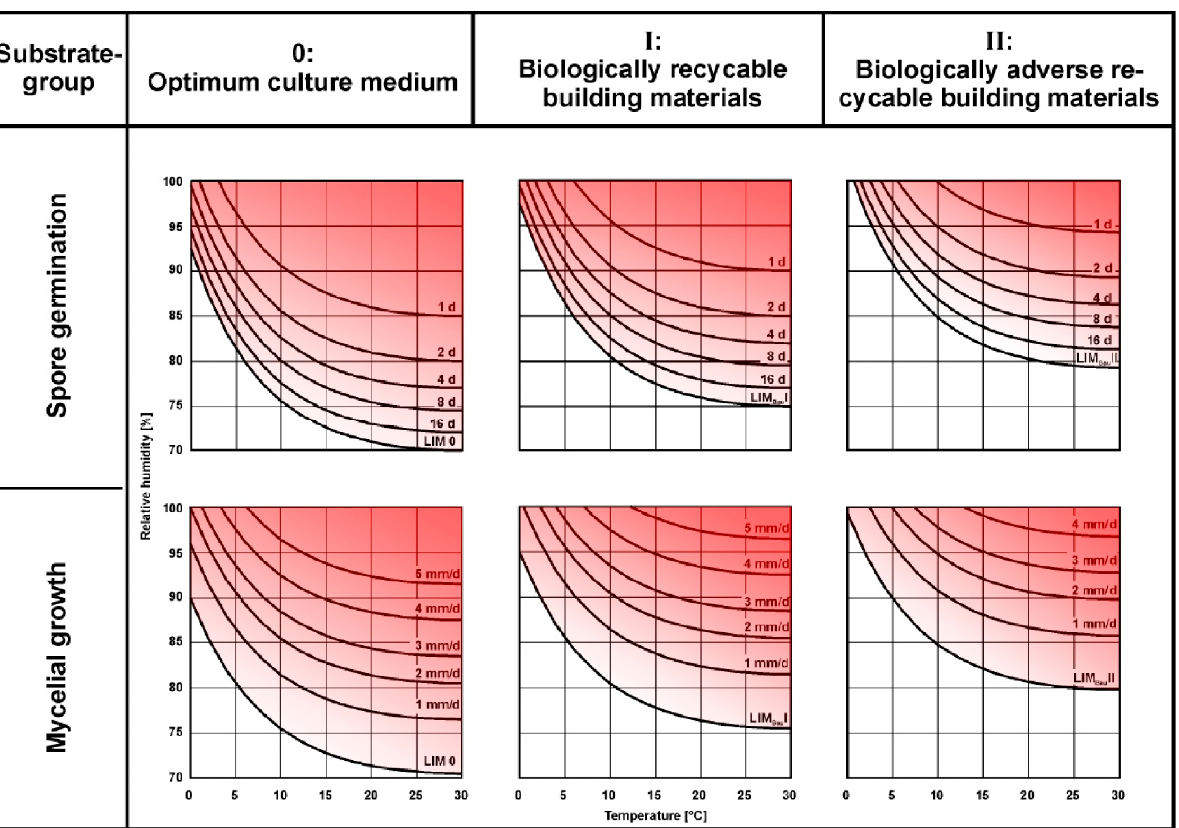
Figure 2. Isolines of spore germination and mould growth for the different categories of substrate. Red areas represent T and RH conditions at risk for spore germination and mycelial growth; the colour intensity indicates higher risk. Adapted from [51].